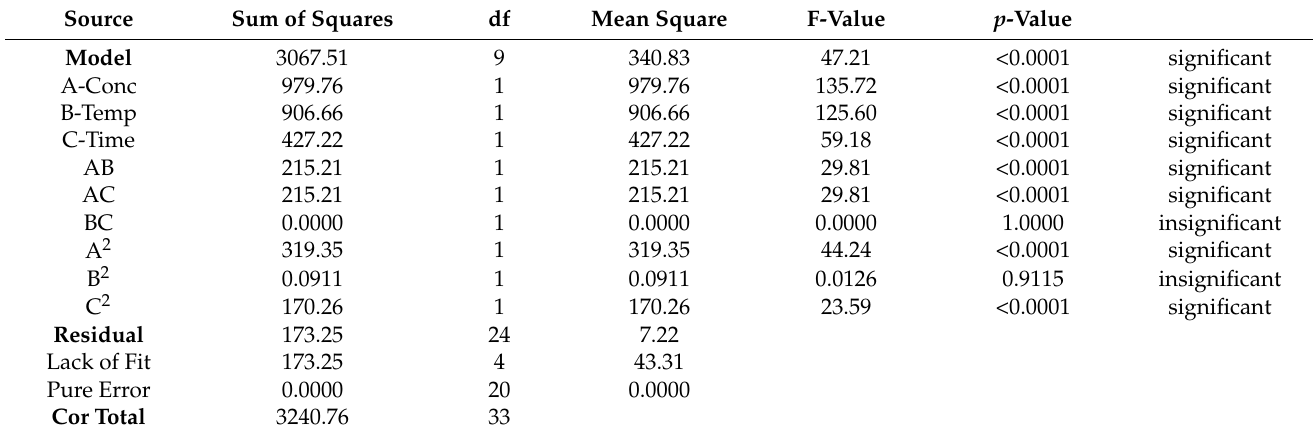
Table 8. ANOVA for Eu Extraction.